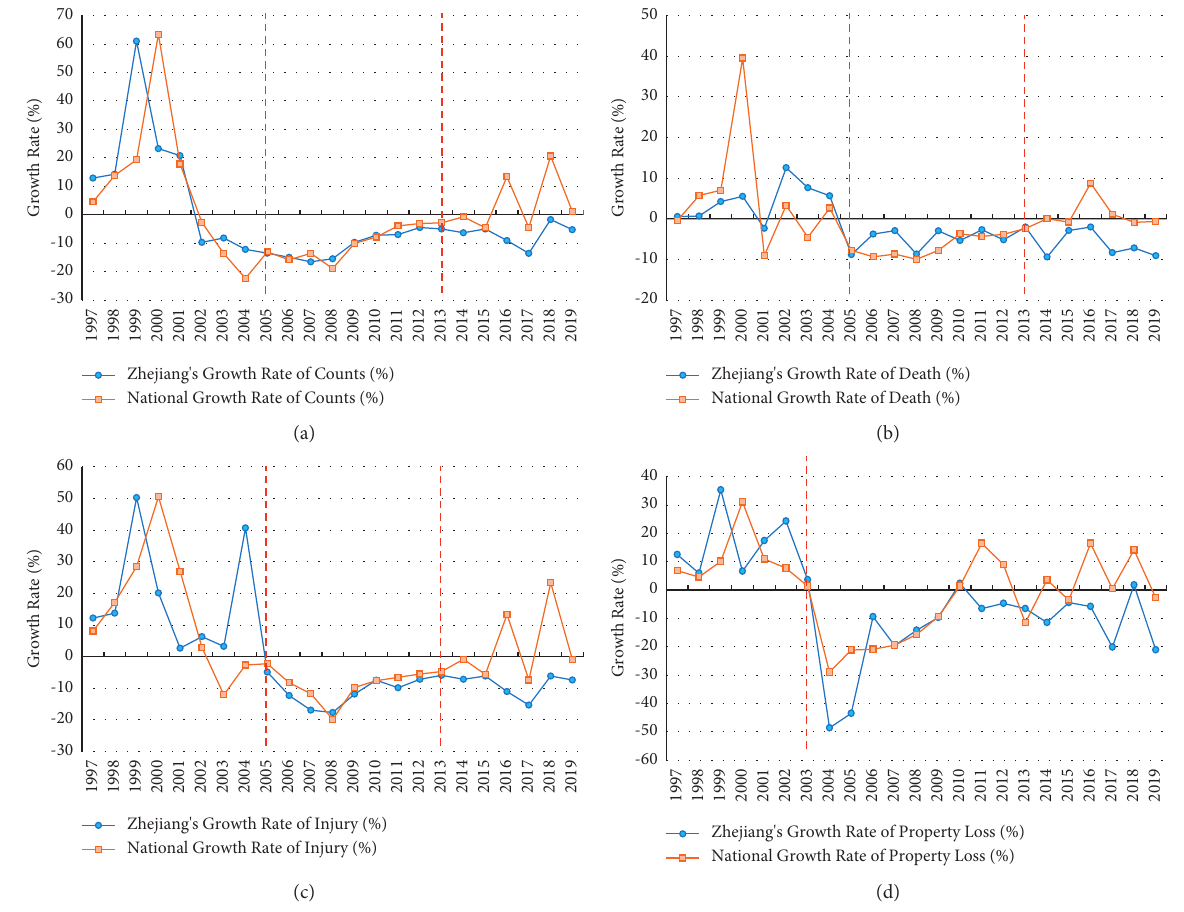
Figure 3: Comparison of the growth rate between the national average and Zhejiang Province (1997–2019). (a) Growth rate of counts. (b) Growth rate of deaths. (c) Growth rate of injuries. (d) Growth rate of property